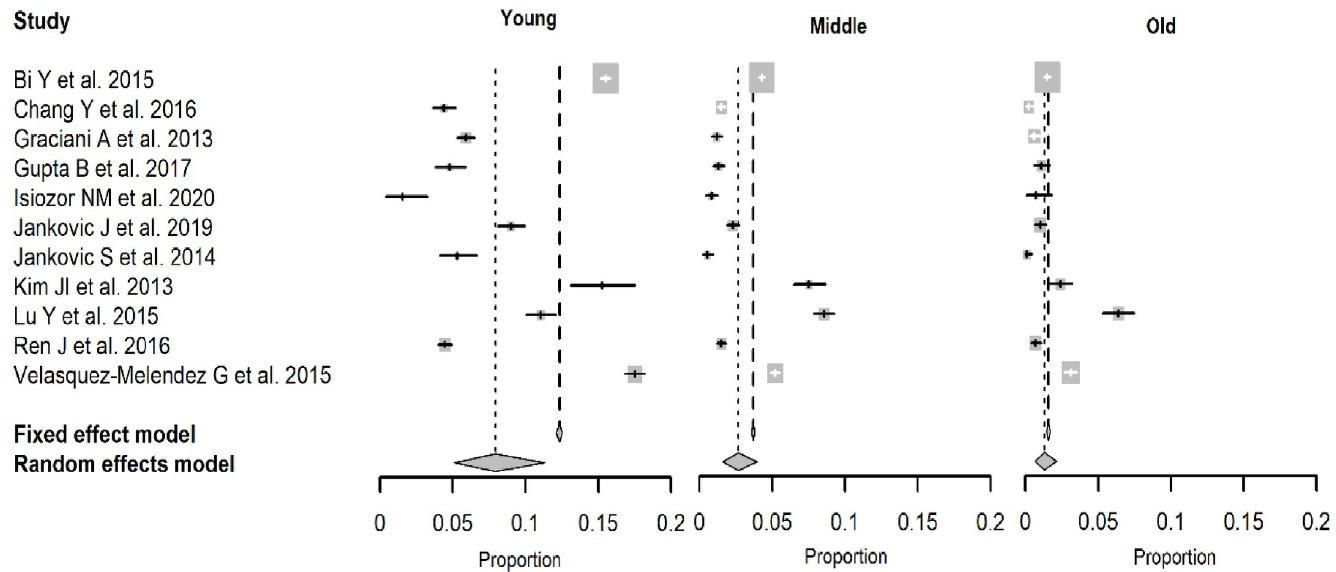
Fig 3. Forest plots depicting proportions with their confidence intervals of ideal cardiovascular health by age group.